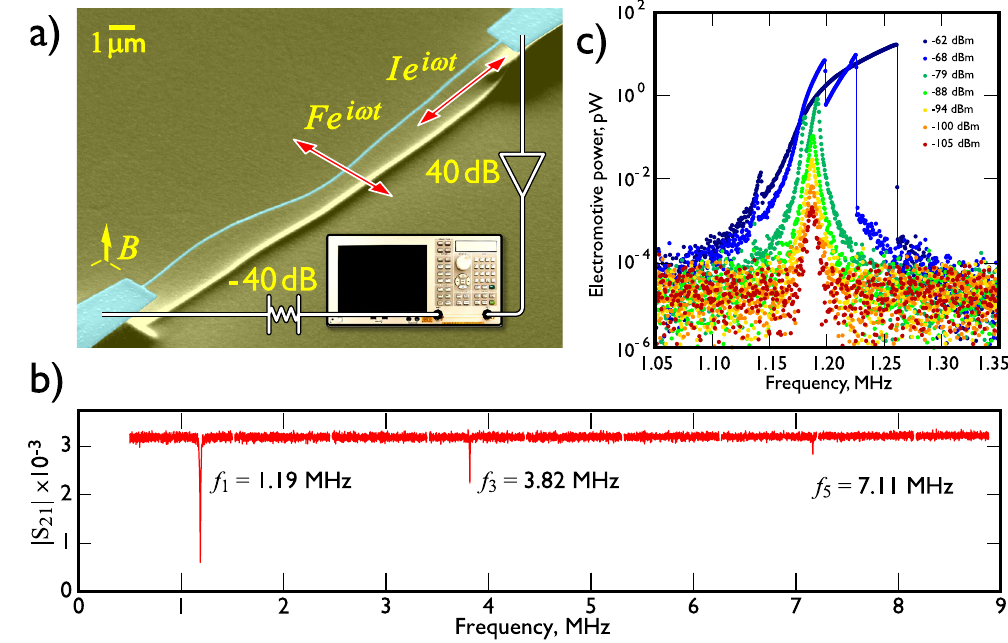
Figure 1. The behaviour of the aluminium beams in vacuum. ( a ) A micrograph of a typical doubly- clamped aluminium beam as used in experiments. Despite an obvious compression of the resonator at room temperature, our beams have a tensile stress at cryogenic temperatures due to the significant differential thermal contraction of the silicon substrate and the deposited aluminium film. The resonator shown here has a nominal length of 15 μ m with cross-sectional dimensions of 0.1 μ m × 0.1 μ m, and an expected resonance frequency at cryogenic temperatures of 8.5 MHz. The beam is placed in a perpendicular magnetic field and connected in the microwave circuit, shown schematically in the figure. Transmission measurements are performed with a network analyser. The microwave drive from the network analyser is attenuated by − 40 dB with an attenuator located at 4.2 K; the microwave signal transmitted through the sample is amplified by a 40 dB amplifier at room-temperature. ( b ) Typical microwave transmission measurements of our 50 μ m beam in vacuum at 4.2 K in a 5 T magnetic field. A wide frequency sweep at − 90 dBm of applied power clearly shows the first three odd harmonics of the beam. The quality factors of all three harmonics are approximately 10 3 . ( c ) The frequency characteristics of electromotive power generated by a 50 μ m aluminium beam measured over a range of applied powers. The beam drive power in dBm is shown in the figure. The typical frequency response shows a Lorentzian shape at low driving power. However, all measured resonators demonstrate a Duffing response at drive powers above − 86 dBm. This particular beam has an additional parasitic resonance becoming visible above − 88 dBm, probably the second “near-degenerate” perpendicular beam